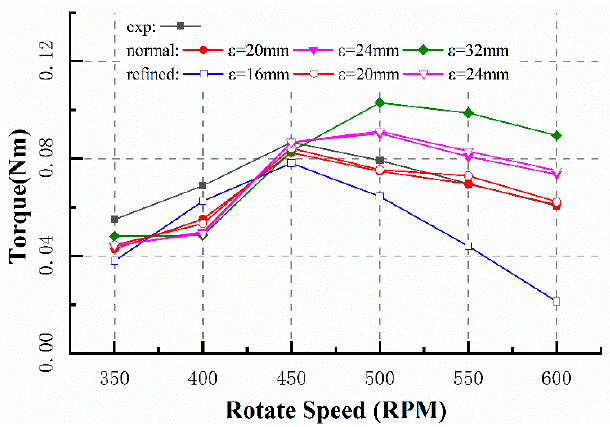
Figure 8. The comparison of torque result with different meshes and different ϵ values. Curves with the same color represent results using different level of mesh but the same Gaussian width.